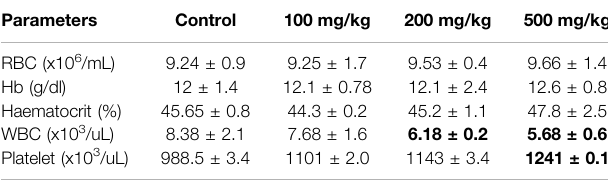
TABLE 4 | The biochemical parameters of mice after 4 weeks of treatment with distinct doses of aqueous extracts of A. vasica.